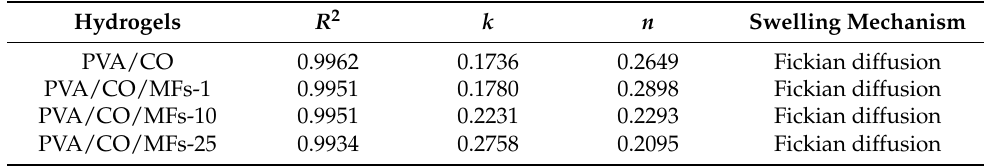
Table 3. Kinetic parameters of swelling.